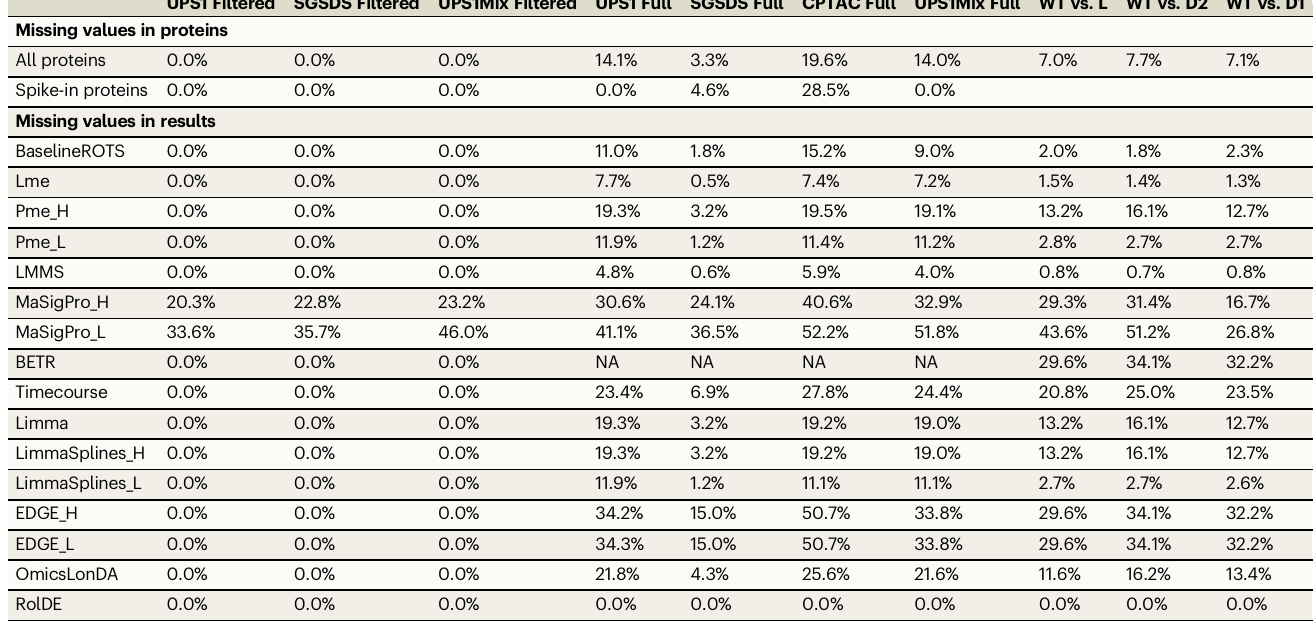
Table 1 | Median proportions of missing values and interquartile range (IQR) mean proportions of missing valid result scores in the semi-simulated spike-in datasets and the experimental Francisella tularensis subspecies novicida